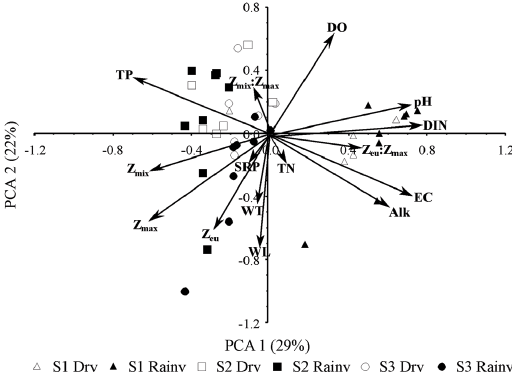
Figure 3. Principal components analysis showing the most related variables to the lakes associated with the dammed river (S1 - Paraná River) and non-dammed ones (S2 - Baia River and S3 - Ivinhema River), in the dry (black) and rainy (white) periods. Water temperature (WT, °C), maximum depth (Z , m), euphotic zone max (Z , m), depth of the mixing zone (Z , m), Z :Z eu mix eu max ratio, Z :Z ratio, dissolved oxygen (DO, mg L -1 ), mix max pH, electrical conductivity (EC, μS cm -1 ), alkalinity (Alk, μEq L -1 ), soluble reactive phosphorus (SRP, μg L -1 ), total nitrogen (TN, μg L -1 ), dissolved inorganic nitrogen (DIN, μg L -1 ), total phosphorus (TP, μg L -1